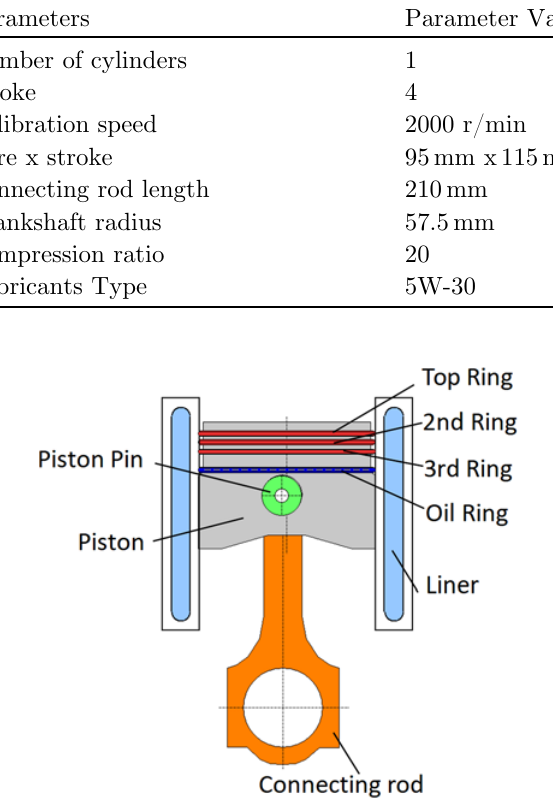
Fig. 2. Dynamics model.